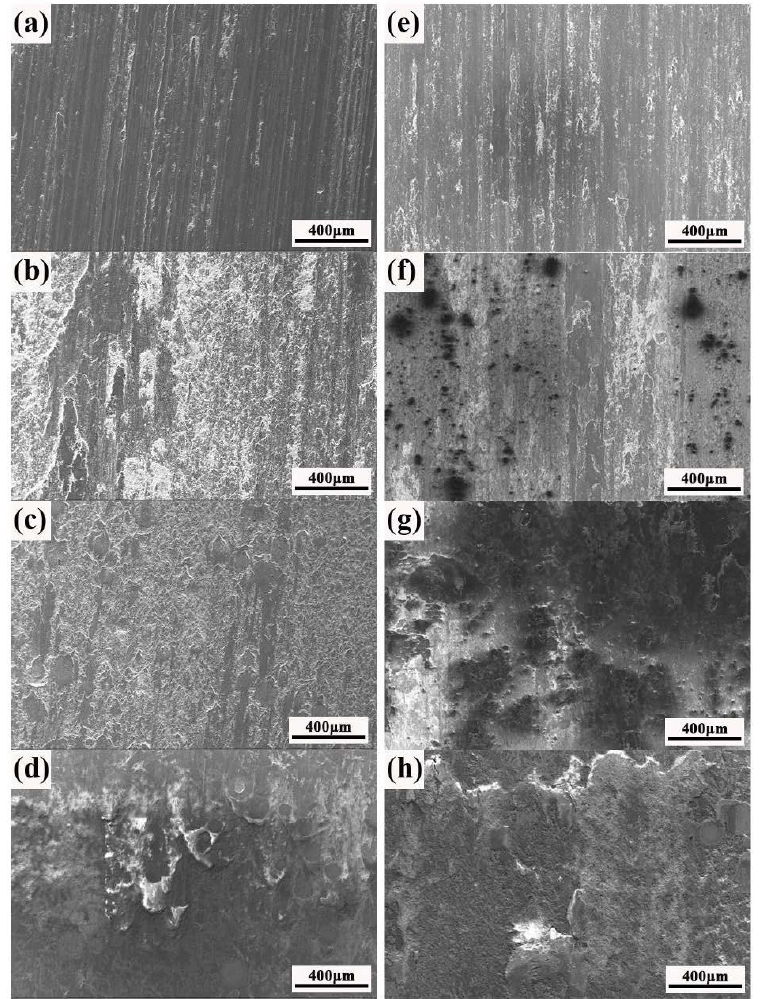
Figure 11. SEM images of worn surfaces with different load. High test load: ( a ) sample A; ( b ) sample B; ( c ) sample C; ( d ) sample D. Low test load: ( e ) sample A; ( f ) sample B; ( g ) sample C; ( h ) sample